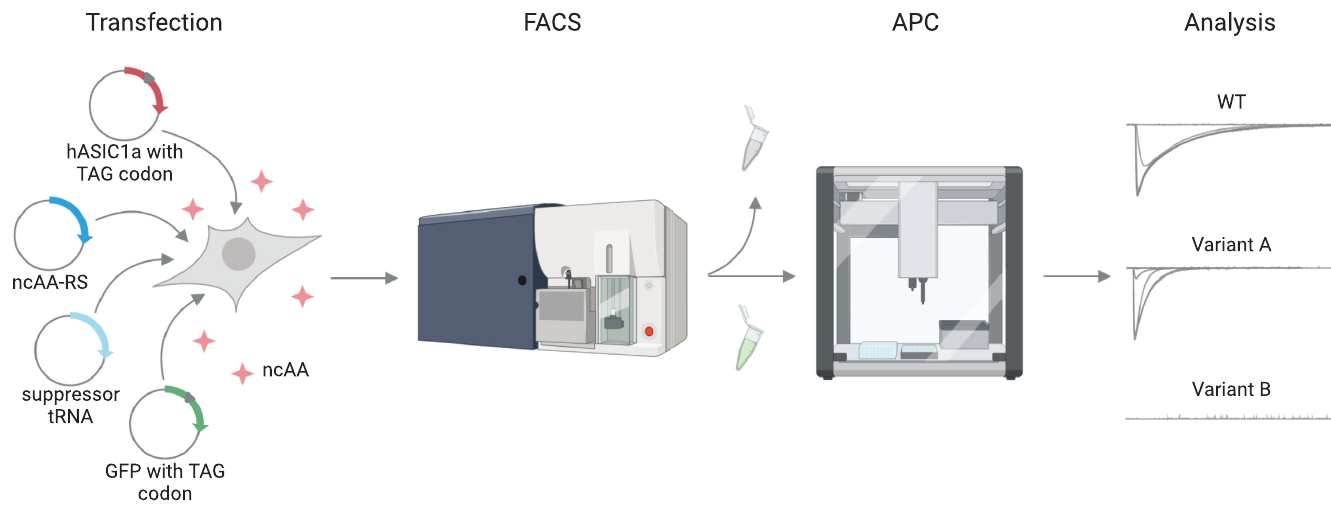
Fig 1. Schematic illustration of the workflow to assess ncAA incorporation into hASIC1a. HEK 293T ASIC1a-KO cells are transfected with hASIC1a containing a TAG stop codon at the site of interest, a coevolved suppressor tRNA/ncAA-RS pair, and a TAG-containing GFP reporter. ncAA is supplied in the cell culture medium. Moreover, 48 hours after transfection, cells are sorted for green fluorescence on a FACS BD Aria I, and those showing fluorescence are subjected to APC on a SyncroPatch 384PE to measure proton concentration response curves. APC, automated patch clamp; FACS, fluorescence-activated cell sorting; hASIC1a, human acid- sensing ion channel 1a; ncAA, noncanonical amino acid; WT, wild